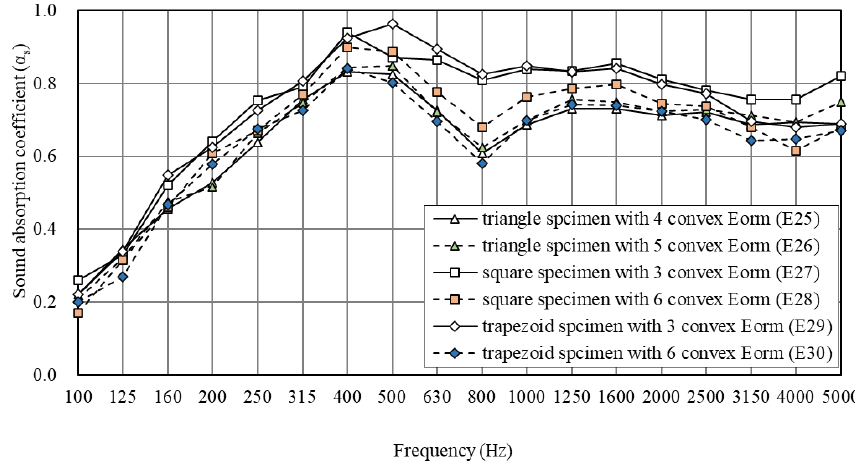
Figure 14. The sound-absorption coefficient of 55 mm FEMM with a 200 mm cavity.